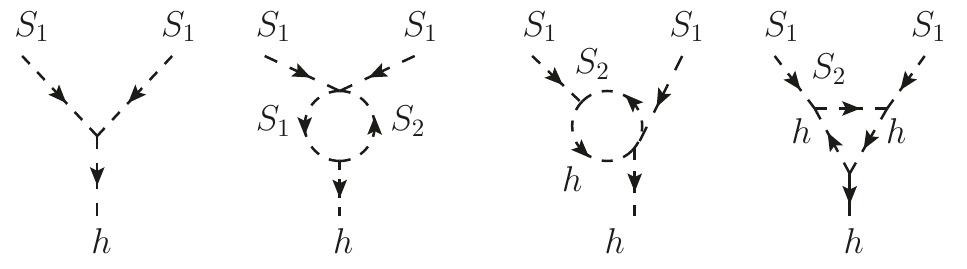
Figure 4 . Tree-level S 1 S 1 h vertex and main 1-loop